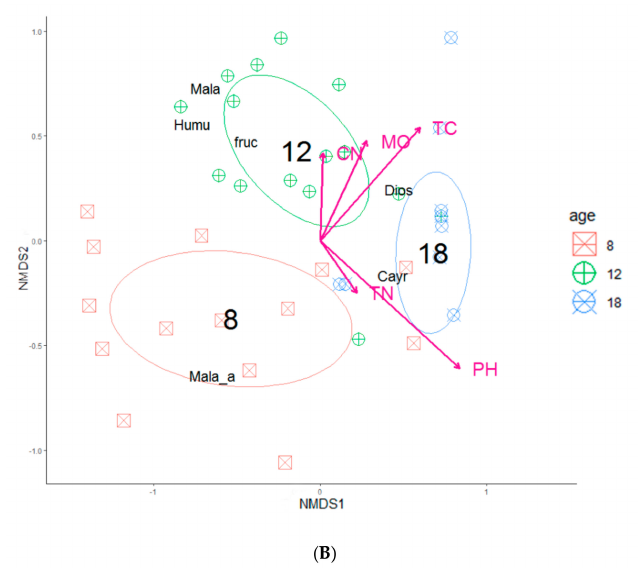
Figure 2. Non-metric multidimensional scaling (NMDS) ordination of study plots across understory species compositions based on ( A ) herb and ( B ) shrub layers across three di ff erent strand ages (8-, 12-, and 18-years). In each diagram, only total carbon and soil pH showed significant goodness of fit based on post-hoc correlations ( p < 0.05) that were represented as vectors. The abbreviated species names in the figures are given Table S1.